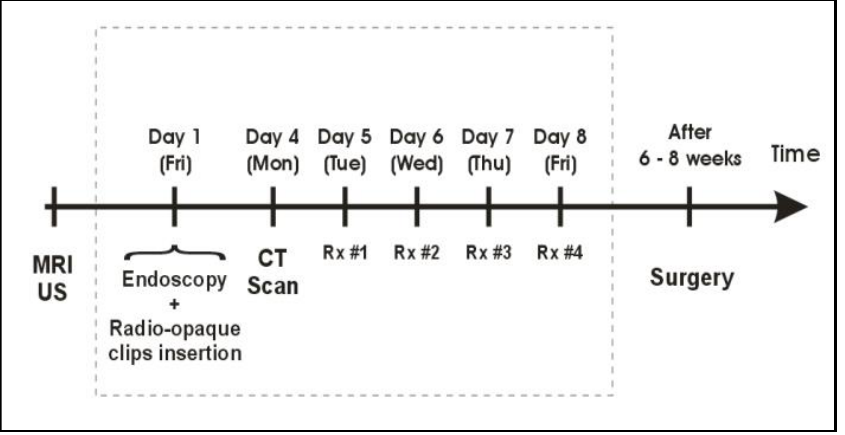
Figure 2. Treatment workflow for pre-operative